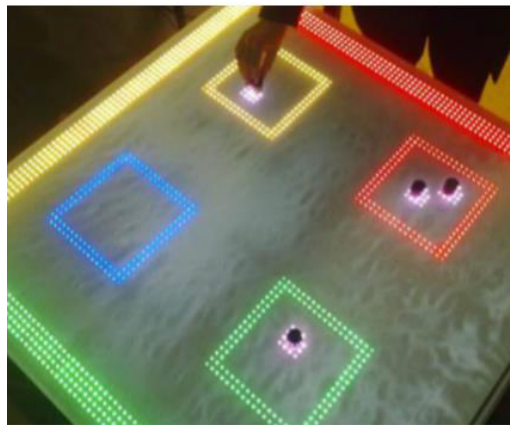
Figure 39. Two ACTOs, a smartphone, and an Arduino with a RF-module [71]. Kubicki et al. from University Lille Nord de France proposed the TangiSense table for interaction with tangible objects (see Figure 40). The TangiSense is a table that is equipped with RFID technology. By manipulating physical objects on the table, the user can simulate the operation according to the displacement of a material object. The technical concept consists of an RFID system (RFID tags), cameras for capturing physical objects, and a touch screen. Virtual objects are visual objects projected onto the table by LEDs that are placed on the table or video projector. Users can manipulate the virtual objects using the glove fitted with RFID tags because RFID tags are monitored by the camera. The camera is reliable, fast, and detects the position of the user’s fingers and objects in images. The implementation of the table using RFID is made of tiles with antennas on the surface. Each tile contains a DSP processor that reads the RFID antennas, the multiplexer antenna, and the communication process. The tiles are connected through the control interface to a PC via an Ethernet line. From these results, the interest in contactless technology and interactive tables is increasing [72].